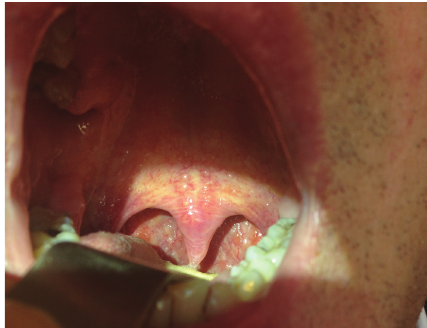
Figure 2: Wrinkling of uvula and the base of uvula (EK sign) in obstructive sleep apnea-hypopnea syndrome.